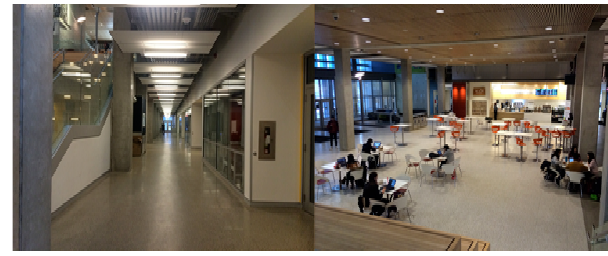
Figure 5 experiment environment in EEEL building